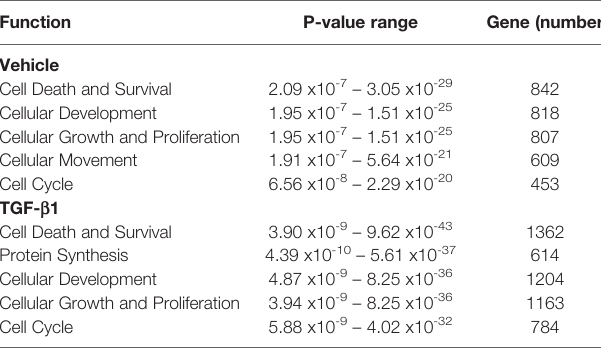
TABLE 3 | The cellular mechanisms most affected by LMTK2 KD in CFBE41o- cells treated with TGF- b 1 or vehicle control.